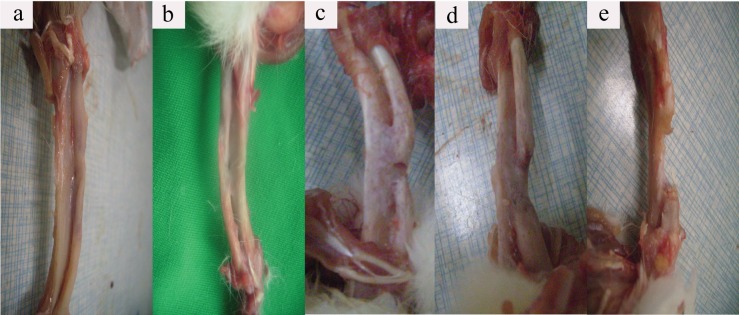
Gross observation of different radius defects after euthanasia at 12 weeks.Both the borders and center of the defects were covered by a newly formed and irregularly-shaped callus, which declined gradually with the defect size increasing (a: 1.0cm, b: 1.2cm, c: 1.4cm, d: 1.7cm, e: 2.0 cm).